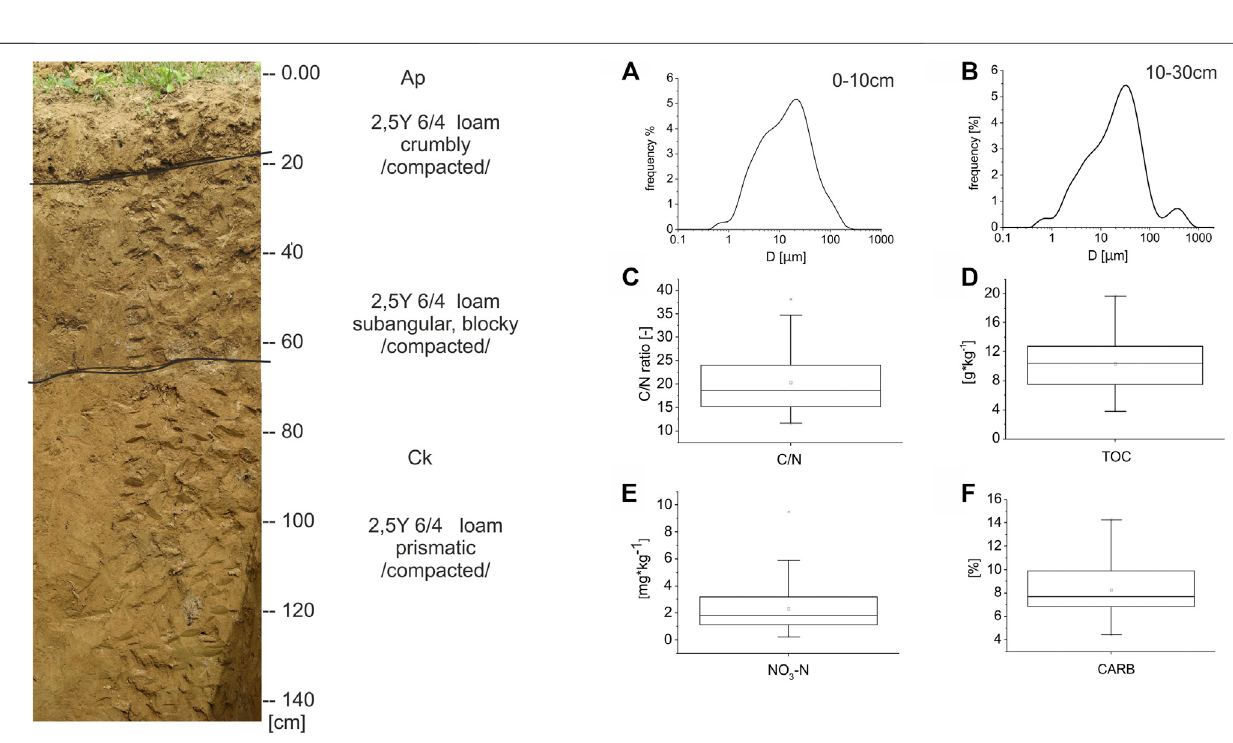
Frontiers in Environmental Science |